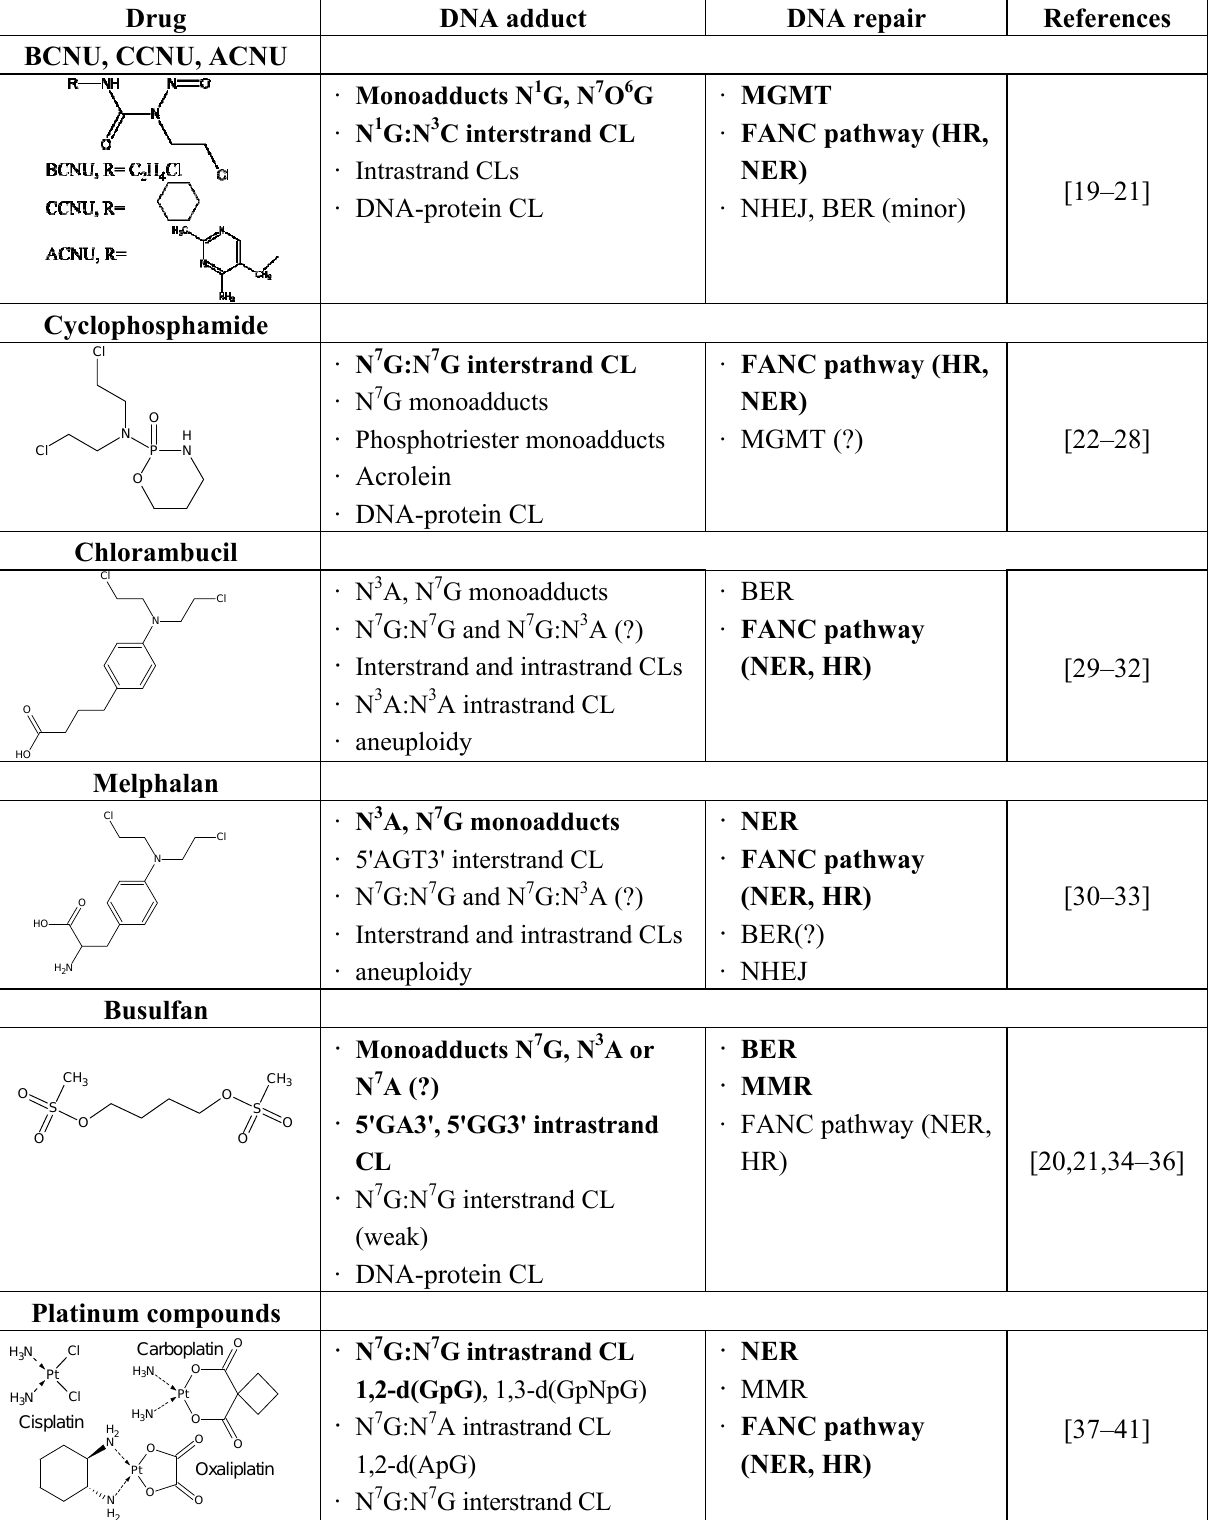
Table 2. Major bifunctional (alkylating) agents associated with the risk of occurrence of t-MN. Drug DNA adduct DNA